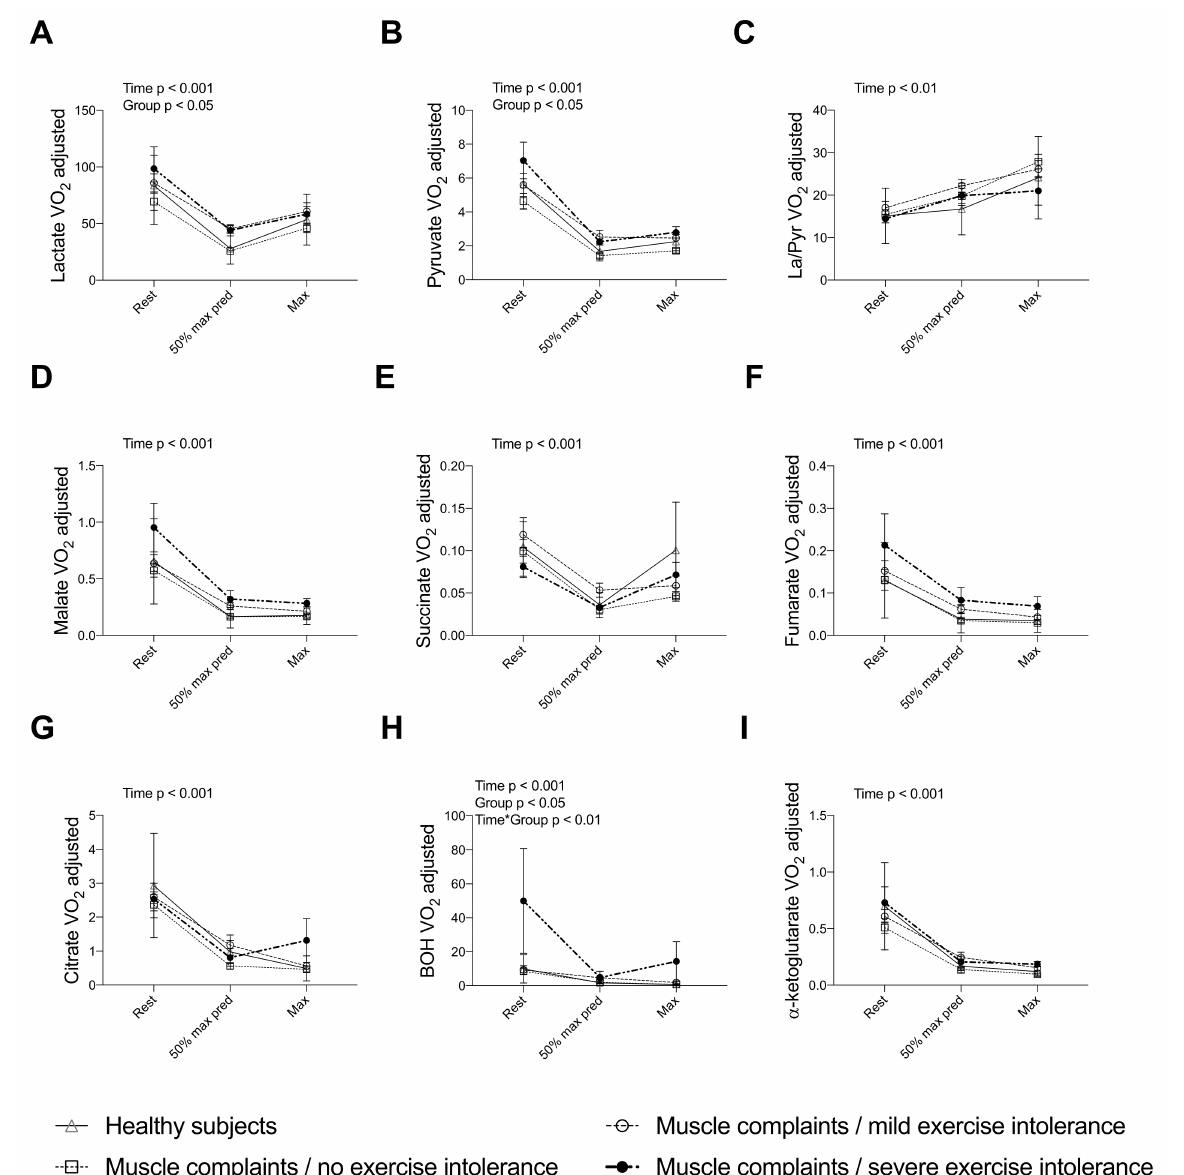
Figure 3. V’O 2 -adjusted TCA cycle intermediates measured by LC-MS/MS in healthy subjects, muscle complaint subjects with no (V’O 2max > 85% pred.), mild (60% pred. < V’O 2max < 85% pred.), and severe (V’O 2max < 60% pred.) exercise intolerance during CPET: ( A ) lactate; ( B ) pyru- vate; ( C ) lactate/pyruvate ratio; ( D ) malate; ( E ) succinate; ( F ) fumarate; ( G ) citrate; ( H ) beta- hydroxybutyrate and ( I ) alpha-ketoglutarate. Each patient was measured at three timepoints: rest, 50% of predicted maximal intensity and at maximal intensity. Data are presented as mean ± SEM at each time point. BOH: beta-hydroxybutyrate; CPET: Cardiopulmonary Exercise Test; La: lactate; Pyr: pyruvate; SEM: Standard Error of the Mean; TCA: Tricarboxylic